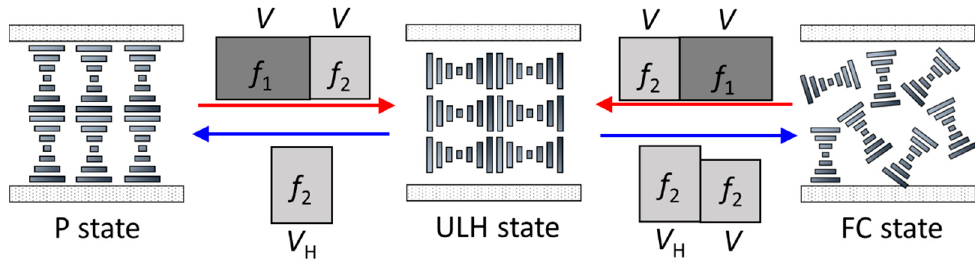
Figure 3. Schematic of the generation of the ULH state and the scheme for textural switching after voltage treatment. Note that f 1 > f 2 .